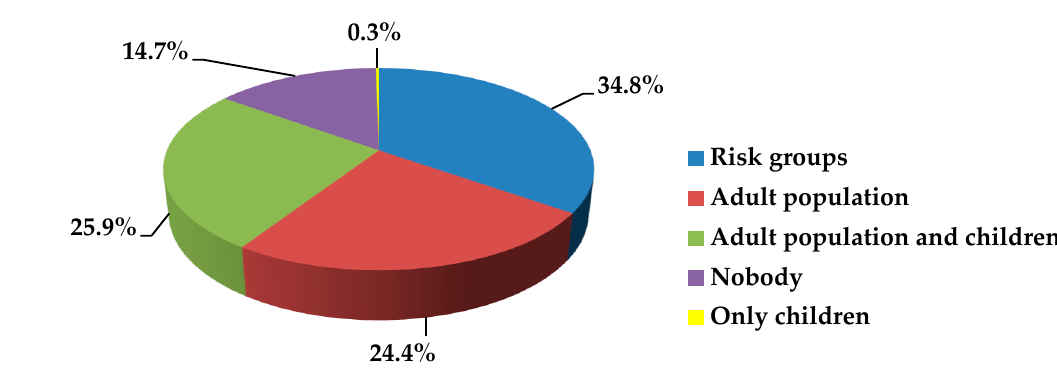
Figure 7. Population groups to be vaccinated against COVID-19.